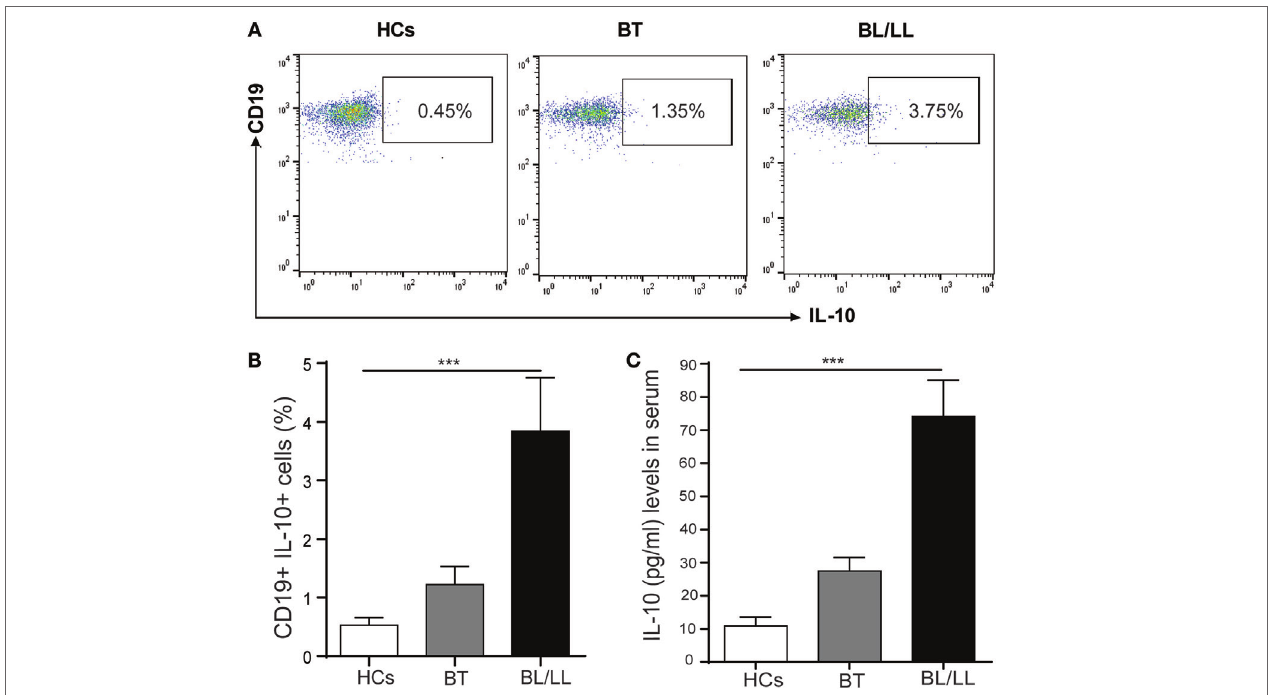
FigUre 1 | B regulatory cells in Leprosy. (a) Representative FACS plot showing enumeration of regulatory B cell (CD19 + IL-10 + ) frequency in peripheral blood mononuclear cells isolated from peripheral blood of HCs, borderline tuberculoid (BT), and BL/LL patient cultured with M. leprae sonicated antigen for 48 h. (B) Graph Plots are showing total interleukin-10 (IL-10) producing CD19 + cells in BT and BL/LL ( n = 25) vs. Healthy Contacts ( n = 10). (c) Graph plot is showing IL-10 level in the serum of HCs and leprosy patients (BT, BL/LL). Mean ± SD values are shown in each set while p value < 0.05 was considered significant. 100,000 cells were acquired and analyzed by flow cytometry. Data analysis was performed with flowjo software. Statistical analysis was done using Student’s t -test for unpaired samples (* p < 0.05; ** p < 0.005; *** p <